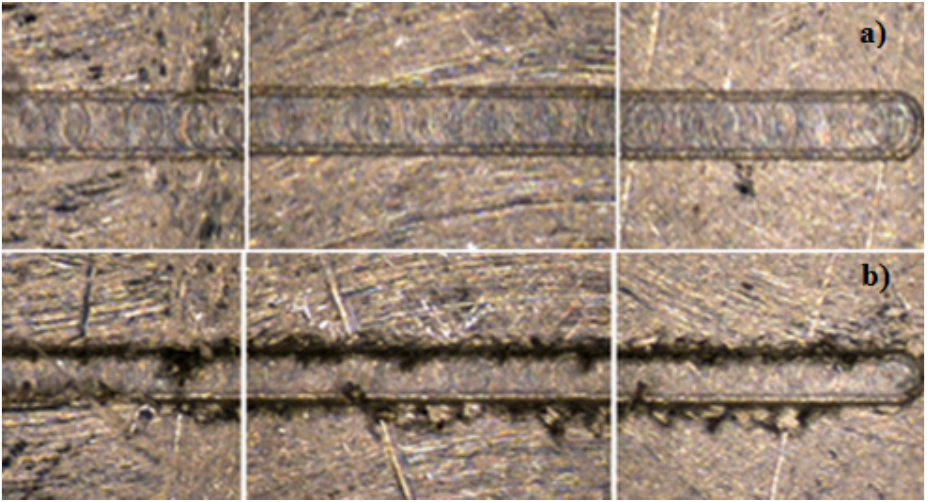
influence in burr formation on Al Alloy. ( a ) Low a p and coolant. p